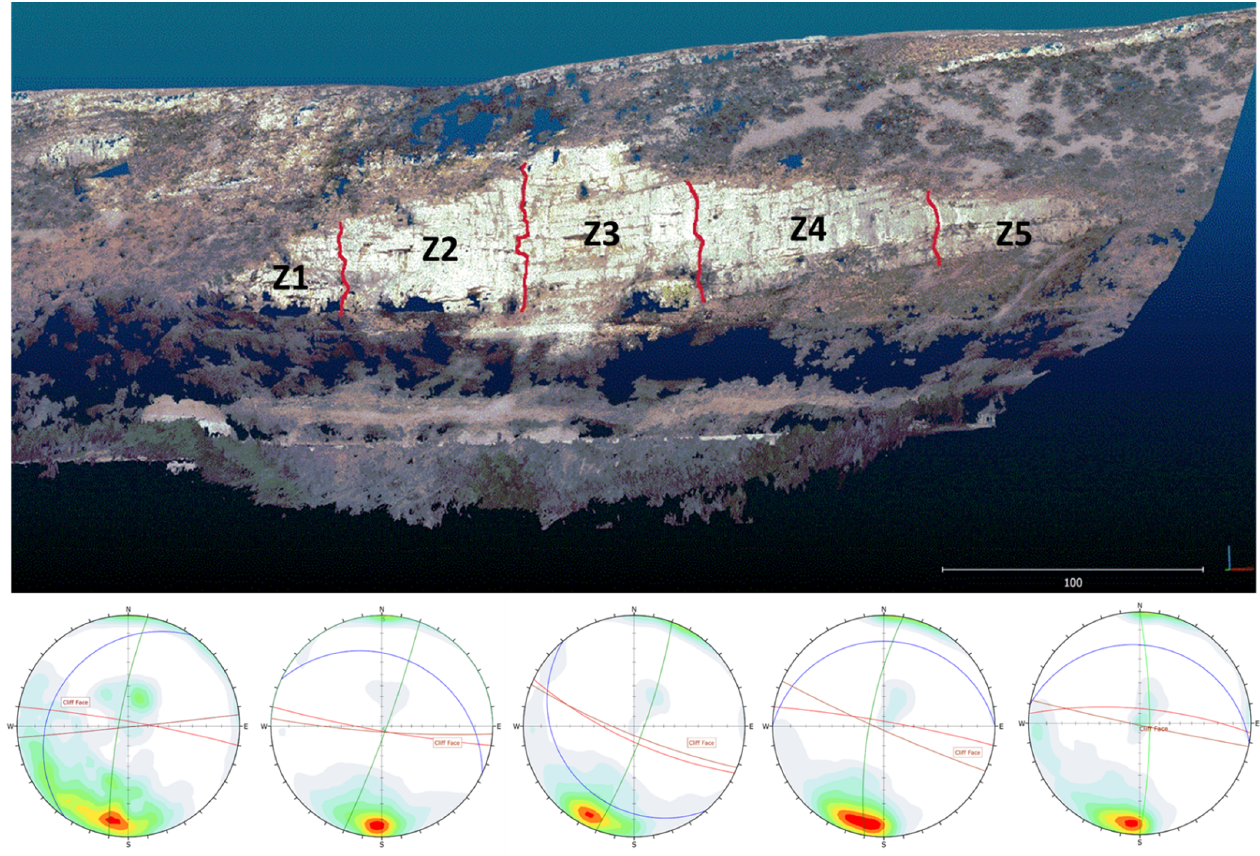
Figure 7. The 3D HR Point Cloud of the Raspadalica Cliff divided into five zones. For each zone the stereograph presentation of the main discontinuity sets (mean value) and orientation of the average cliff slope is presented. The concentration of plane poles quasi-parallel to cliff face is visible on each stereogram (from white (cold) with no or several poles to (hot) with high concentration of poles). Red is transversal of the average cliff face, other represent transversals of joint sets.